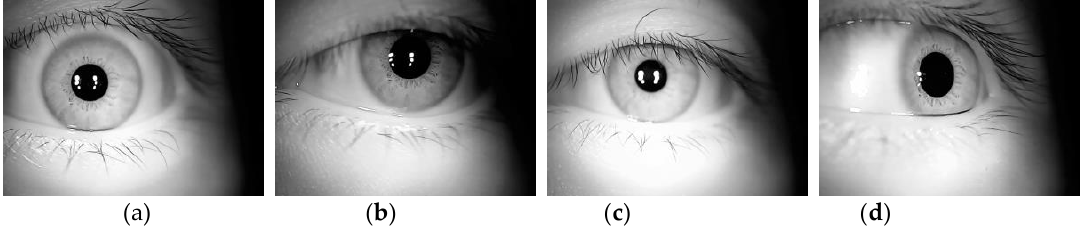
Figure 3. Examples of multi-state irises: ( a ) normal iris, ( b ) iris with dark condition, ( c ) iris with defocused condition, ( d ) iris with deflected condition.